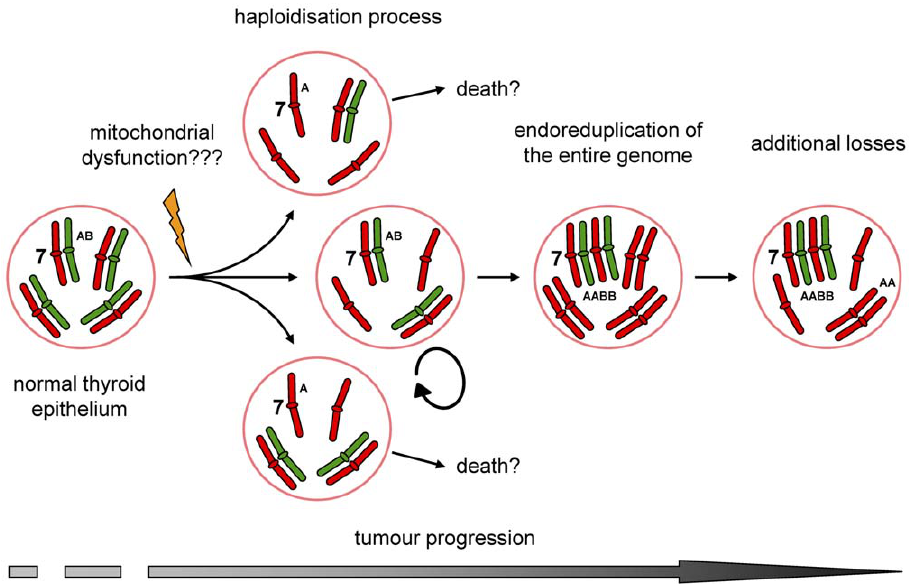
Figure 5. Hypothetic model of oncocytic follicular thyroid carcinoma development and progression. Mutations in mtDNA underlie low levels of ATP productions. In order to compensate for these low energy levels mitochondria carrying these mutations proliferate and accumulate in the cytoplasm of affected cells. Oncocytic FTC is also characterised by a mitochondria-rich cytoplasm, are known to harbour mtDNA mutations (mainly complex I) and do show a disturbed energy production. DNA replication and progression through the cell cycle are energy demanding processes. Low energy levels might also disturb normal formation and function of the mitotic spindle, resulting in an unbalanced mitosis. Cells that have lost chromosomes during several rounds of cell division become DNA near-haploid (haploidisation process). Sustaining a near-haploid genome may require less energy than of normal 2n cells. Consequently near-haploid cells show a growth advantage and are selected for during tumour development. Maintaining chromosome 7 in heterozygous state ([AB]) seems to be essential for tumour survival. This might be indicative for the presence of genes playing an important role in oncocytic FTC. Endoreduplication of these genes into an [AABB] allelic state increases the gene dosage which might be beneficial for further